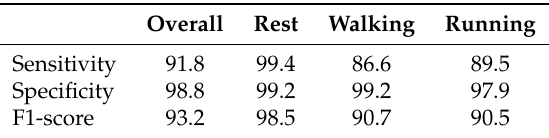
Table 3. Classification results, using the smart annotation model (SA-GZ4), on continuous test data on a per sample basis. All calculated per person and then per class and displayed as a